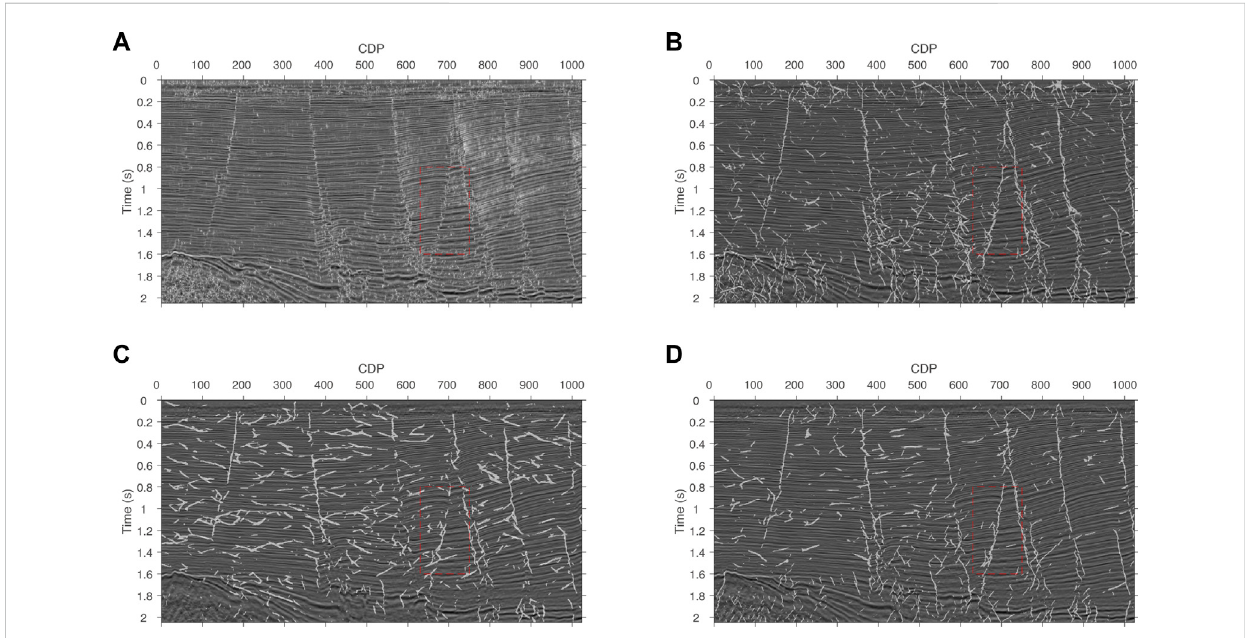
prediction on the real data. The real seismic section is painted in Figure 8. In Figure 8, some faults are easy to notice directly, which have been marked by red lines. For a seismic fault detection task,